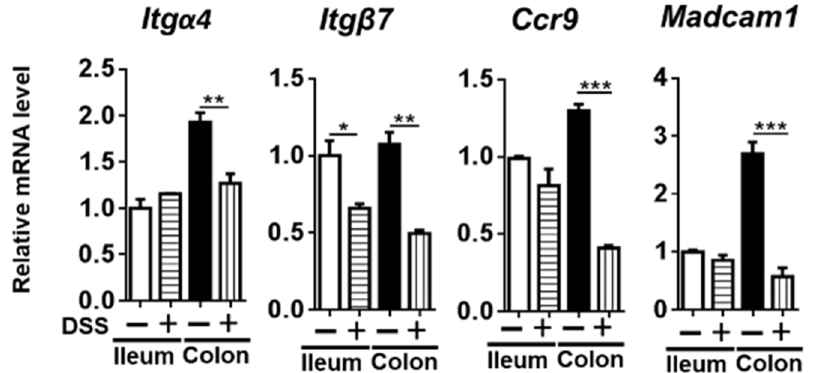
Figure 7. Gut-homing signaling gene expression in the ileum and colon of mice treated with or without DSS. Data are expressed as mean ± SD. n = 9 per group. Student’s t -test. * p < 0.05, ** p < 0.01, *** p < 0.001.